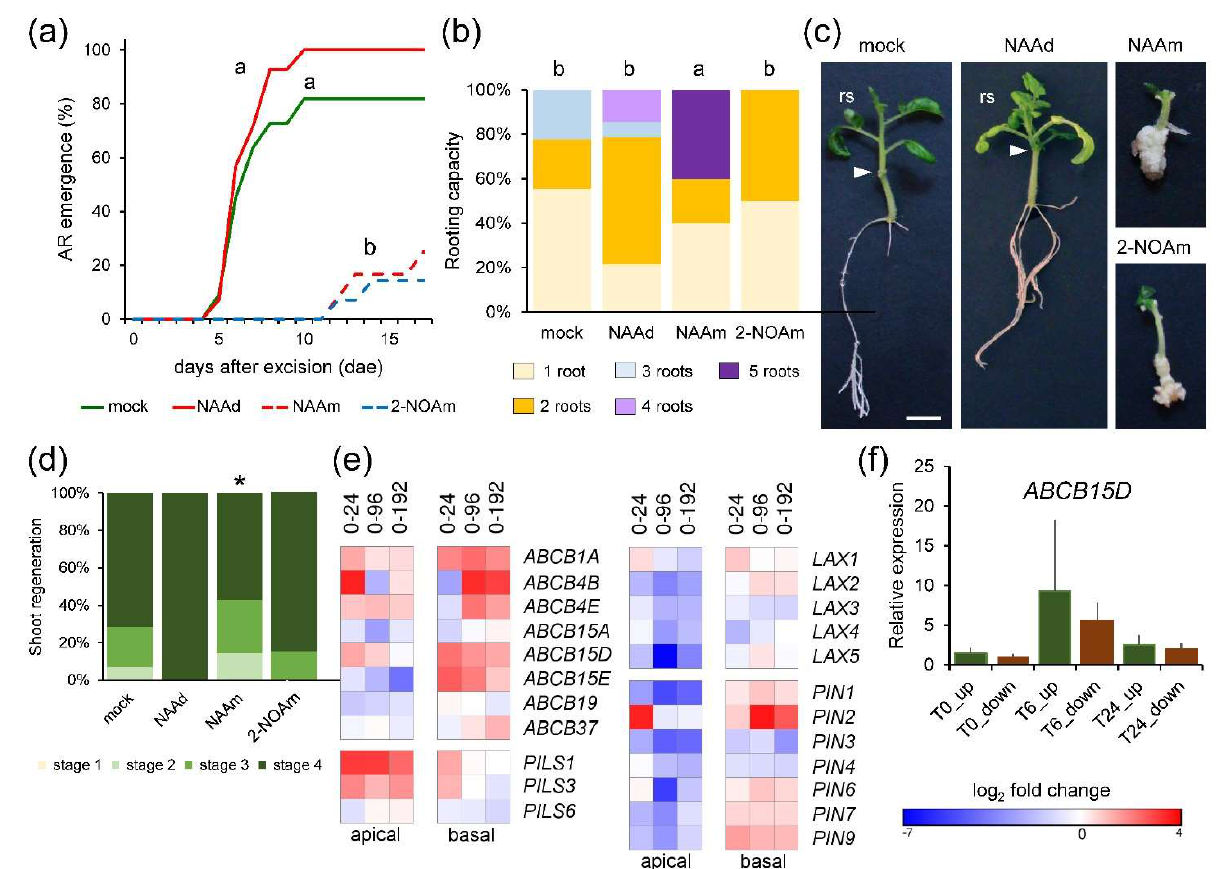
Figure 3. Regulation of auxin pathway genes during de novo organ formation. ( a , b ) AR emergence ( a ) and rooting capacity at 14 dae ( b ) of whole hypocotyl explants in response to the indicated treatment; NAAm: 0.3 µ M NAA added to the growing medium; NAAd: 0.3 µ M NAA added to the distal end of the hypocotyl explants; 2-NOAm: 40 µ M 2-NOA added to the growing medium. ( c ) Representative images of the hypocotyl explants at 21 dae. Arrowheads indicate the apical end of the hypocotyl explants at 0 hae; rs: regenerated shoot. ( d ) Shoot regeneration stages of ‘Micro-Tom’ explants at 17 dae. Different letters ( a , b ) and asterisk ( d ) indicate significant differences ( p -value < 0.05) between the treatments. ( e ) Differential expressed genes (DEGs) involved in auxin transport. Expression values of DEGs (false discovery rate [FDR] < 0.01) were in log 2 fold change relative to 0 hae according to the scale bar in the figure. ( f ) Relative expression levels of ABCB15D at 0, 6 and 24 hae in apical (green bars) and basal (brown bars) regions of the whole hypocotyl explants. Scale bars in c: 5